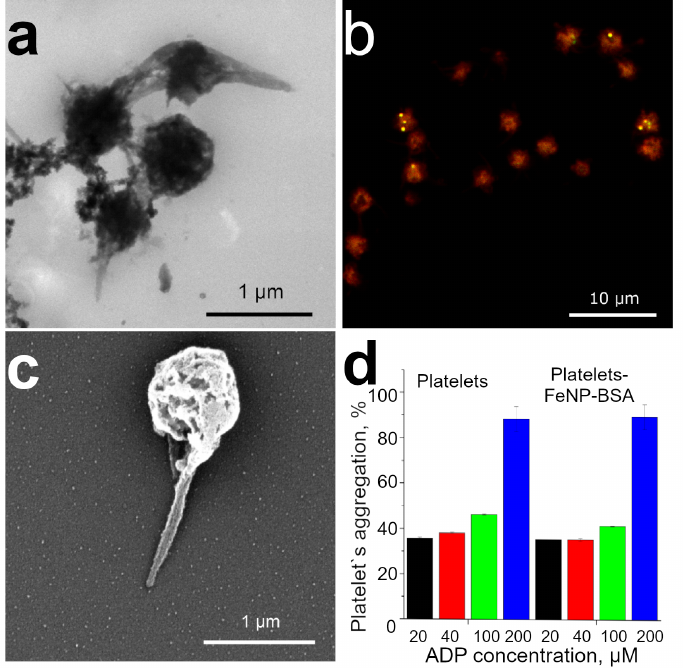
Figure 2. ( a ) TEM images, ( b ) CLSM, ( c ) SEM images of FeNP-BSA labeled platelets. ( d ) Platelet aggregation of non-labeled controls (platelets) and BSA-labeled (platelets-FeNP-BSA) platelets after addition of various concentrations of ADP inductor (mean ± SD, n =